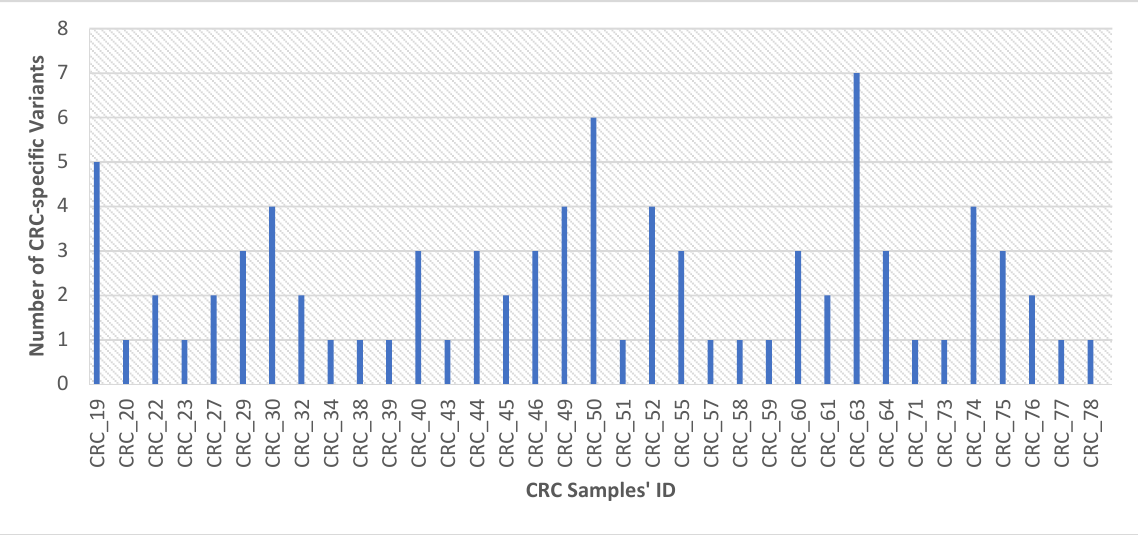
Figure 4. Distribution of somatic variants that were identified merely in CRC samples. PIK3CA (NM_006218) and four in FBXW7 (NM_001013415), as shown in Table 3. These PIK3CA and FBXW7 mutations were reported in seven and four cases, respectively. Out of these 10 novel mutations, 8 mutations were found in the CRC group only, while a mu- tation in PIK3CA (c.1013T>A) is found in CP group only and a single mutation in FBXW7 (c.248C>T) is found in IBD group. The ten novel mutations have not been previously re- ported in any of the public databases.